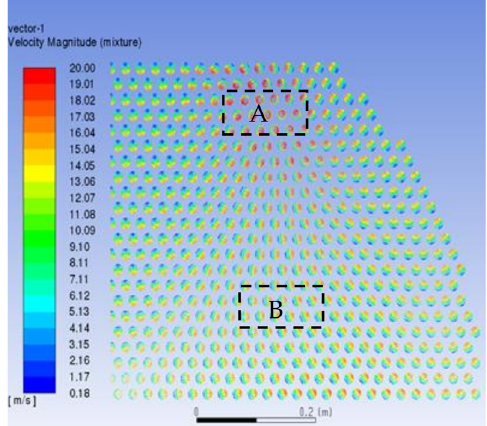
Figure 11. Velocity vector diagram of tube bundle inlet. ( A ) the vortex core region and ( B ) the peripheral area.